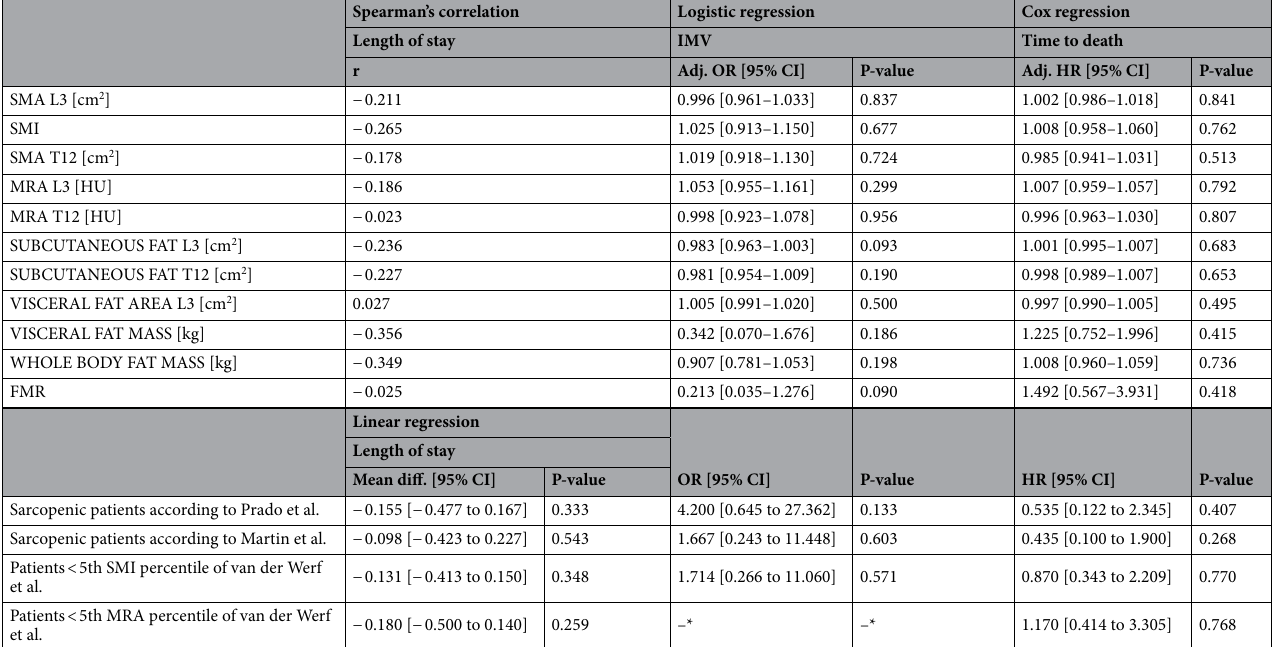
Table 3. Relationship between body composition parameters, sarcopenia classification results, and the clinical outcome parameters length of stay, invasive mechanical ventilation (IVM), and time to death. Regression analyses for the metric independent variables were adjusted for sex, age, and body mass index (BMI). Detailed results for all adjusting variables are listed in Supplement Table 1. IMV = invasive mechanical ventilation, SMA = skeletal muscle area, L3 = at the level of the third lumbar vertebra, SMI = skeletal muscle index, T12 = at the level of the twelfth thoracic vertebra, MRA = muscle radiodensity attenuation, HU = Hounsfield units, FMR = fat to muscle ratio, adj. OR = adjusted odds ratio, CI = confidence interval, Adj. mean difference = adjusted mean difference, Adj. HR = adjusted hazard ratio. *Model not applicable due to low